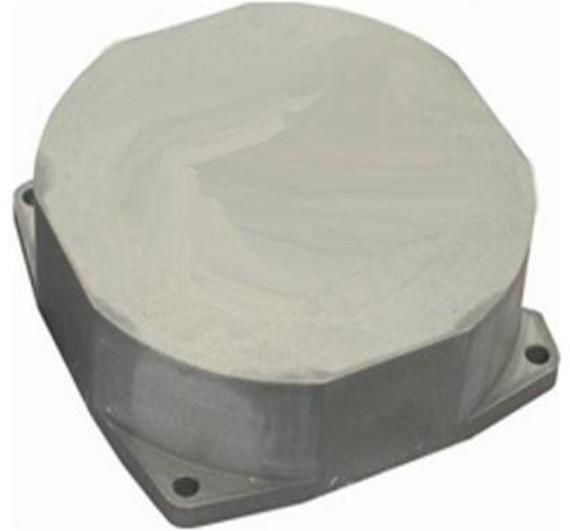
Figure 18. Low-precision